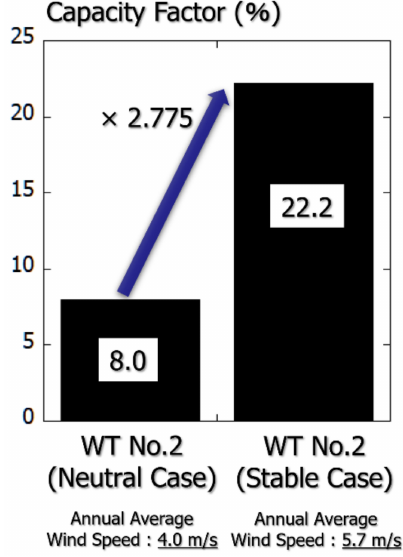
Figure 27. Comparison of capacity